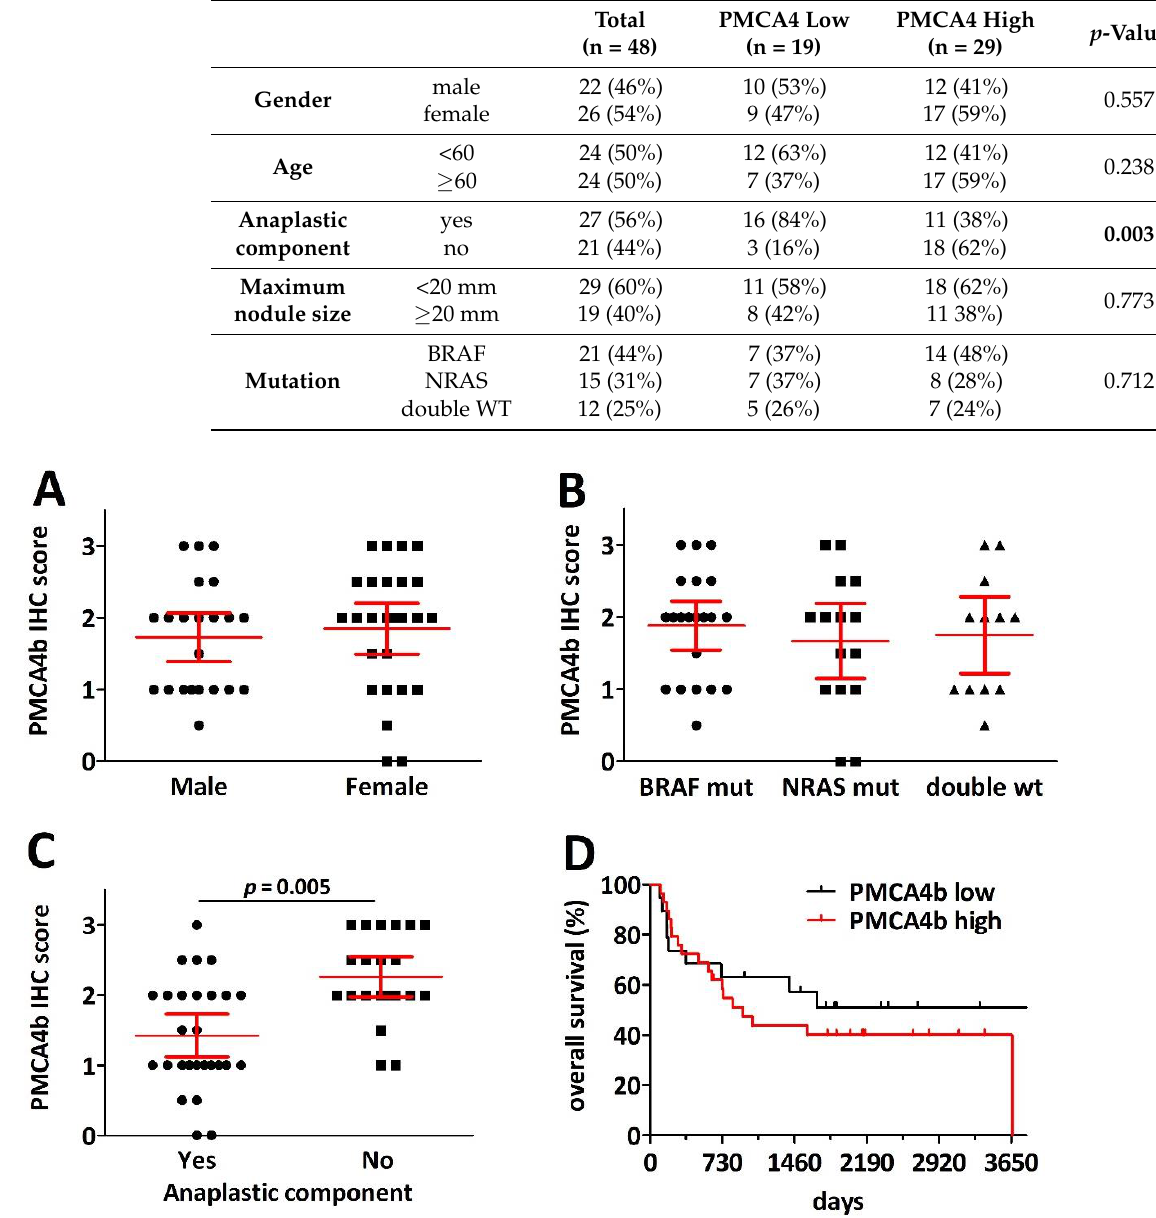
Table 3. Clinicopathological characteristics of the melanoma lung metastasectomy cohort.